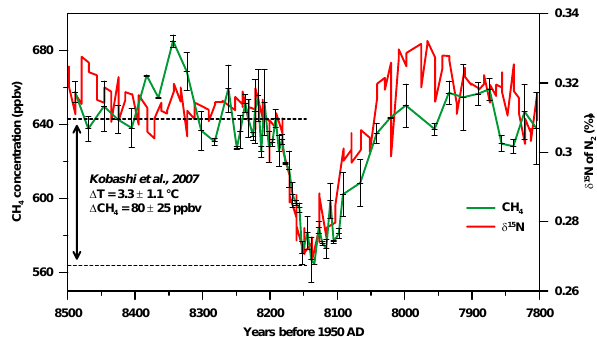
Fig. 1. Evolution of Greenland temperature and atmospheric methane concentration during the 8.2kyr event. The measured δ 15 N signature allows for a quantitative temperature reconstruction and represents a temperature change of about 3 ◦ C over Central Green- land which is accompanied by an 80ppb decline in atmospheric CH 4 (Kobashi et al.,